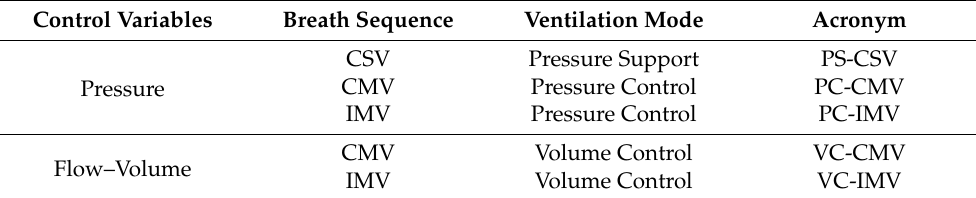
Table 1. Mechanical ventilation modes, adapted from